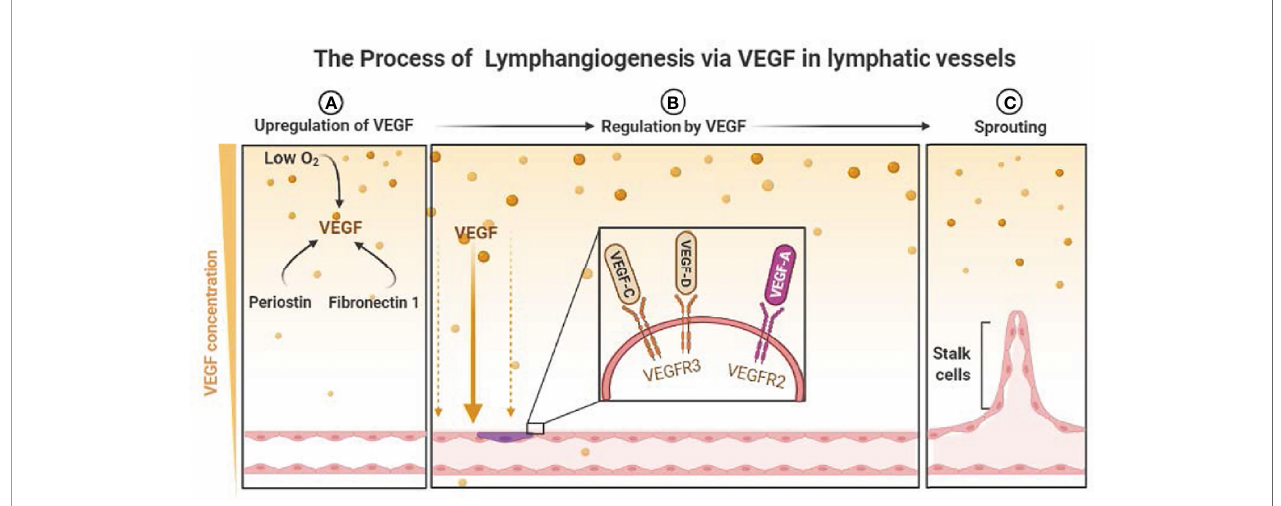
FIGURE 1 | The Process of Lymphangiogenesis via VEGF in lymphatic vessels. (A) Low O 2 and some molecular induce the upregulation of VEGF. (B) The regulation of lymphangiogenesis by the link of VEGFs and VEGFRs. (C) The sprouting of lymphatic vessels. (P.S. Created with